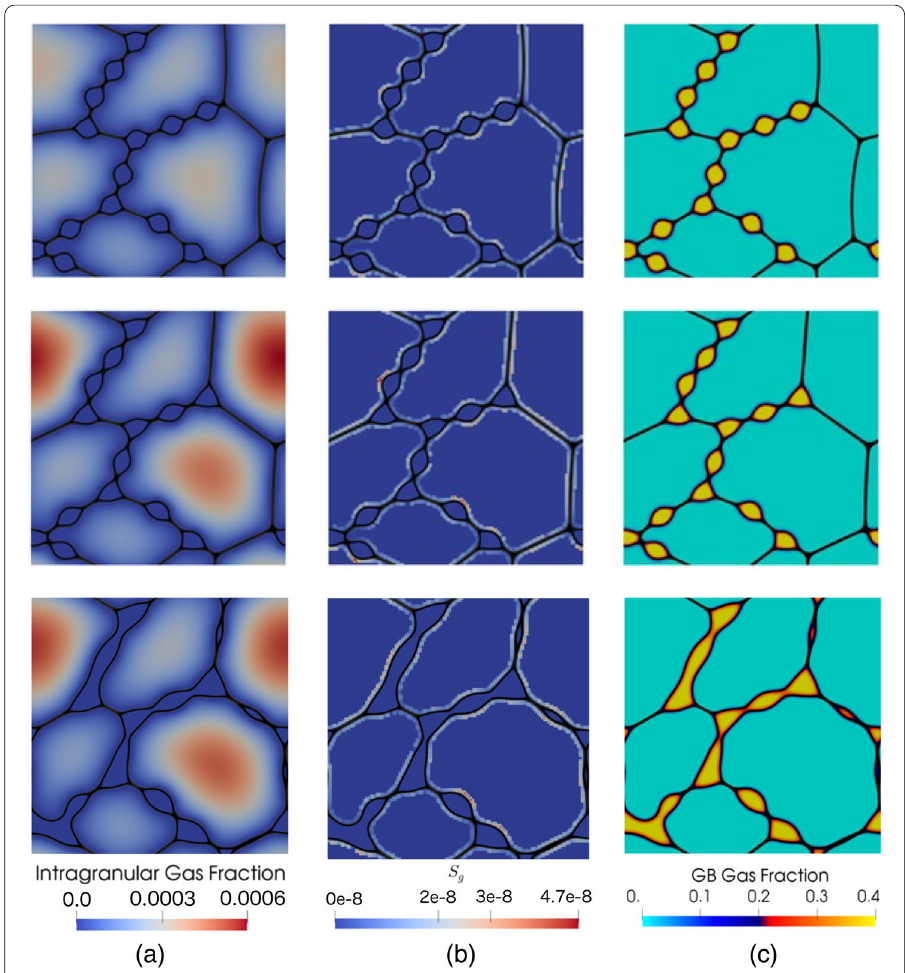
Fig. 4 Evolution of the microstructure over time predicted by the coupled model; ( a ) shows the intragranular gas fraction predicted by Xolotl; ( b ) shows the arrival rate of gas at the interfaces transferred from Xolotl to MARMOT; ( c ) shows the GB gas fraction predicted by MARMOT. In each, the top image shows the microstructure after 20 days, the middle image after 127 days, and the bottom image after 1389 days. The interfaces are shown in